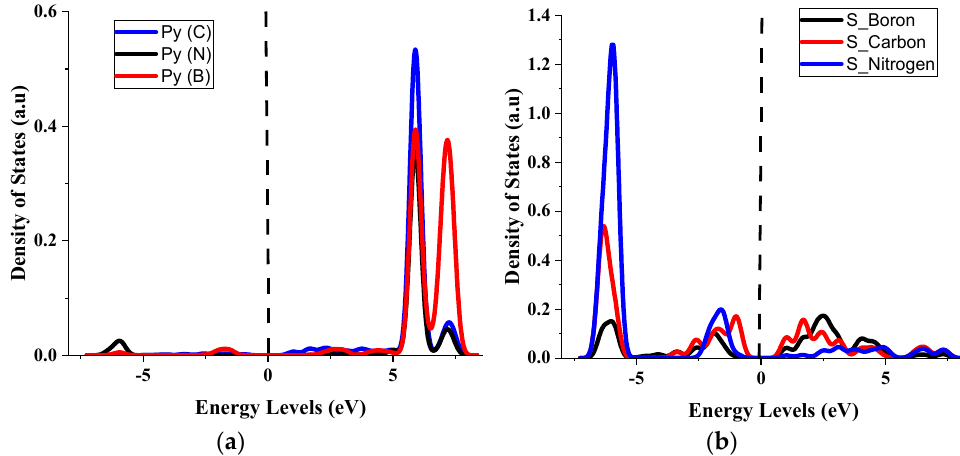
Figure 6. ( a ) P y contributions for B, C, and N, respectively; ( b ) S contributions for B, C, and N, respectively.